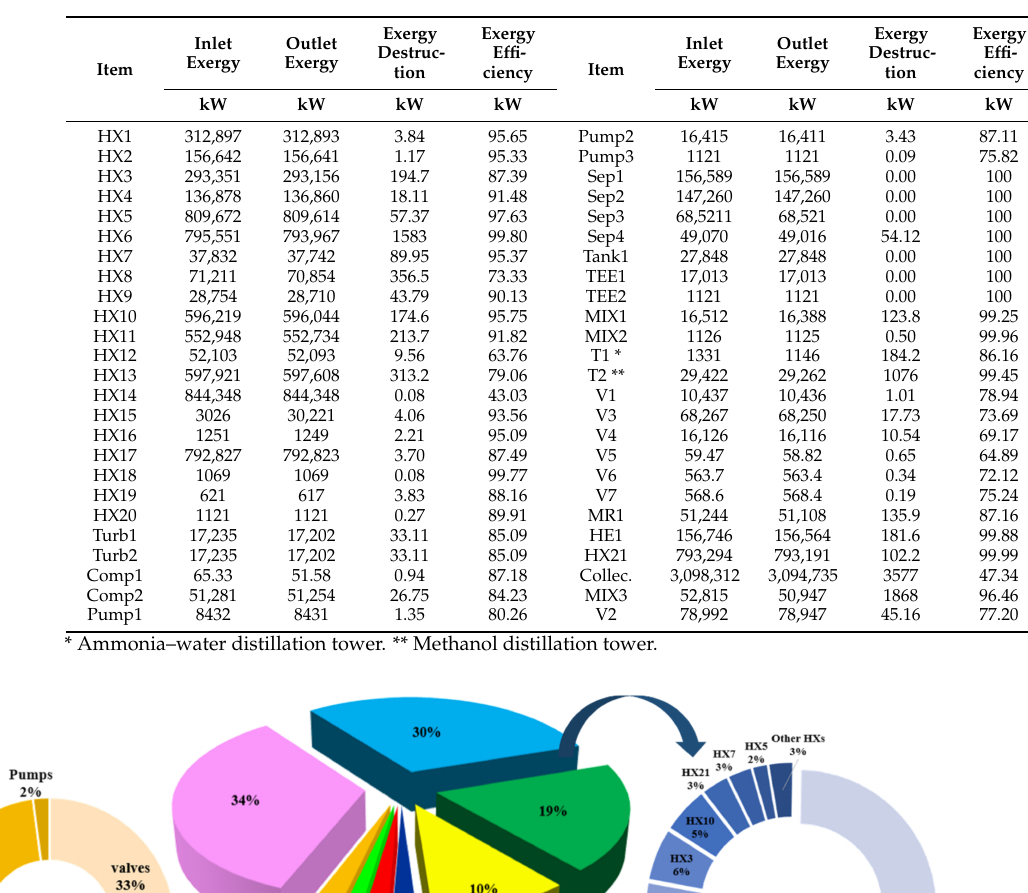
Table 3. Inlet and outlet exergies, exergy efficiency, and exergy destruction of each piece of equipment.